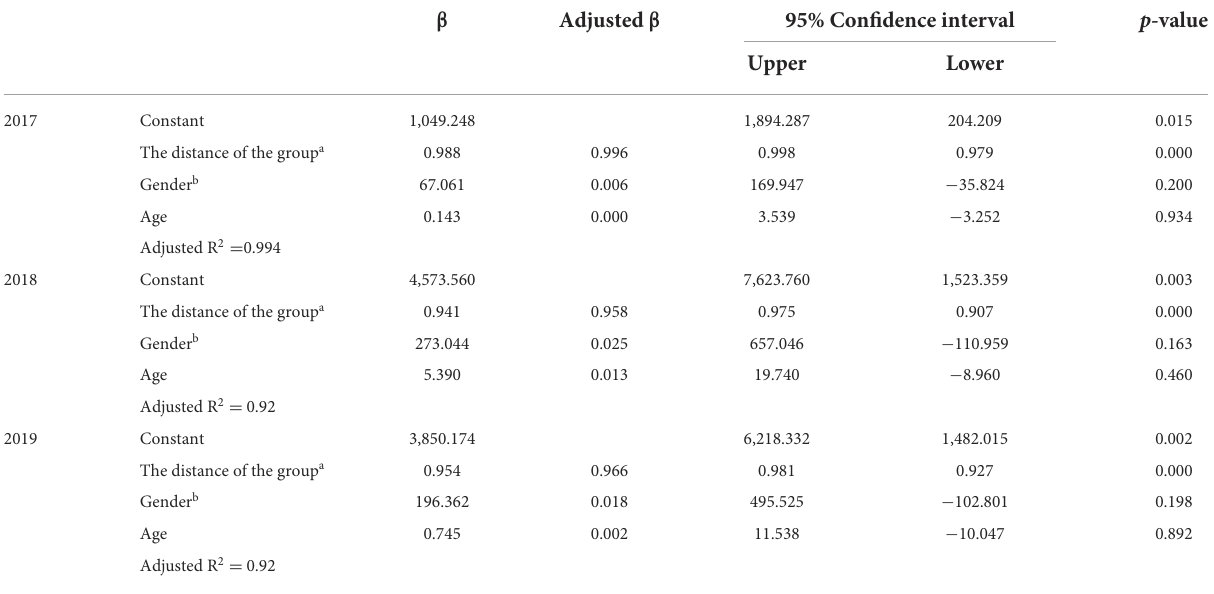
TABLE 9 Predictive accuracy of hypertension (multiple regression